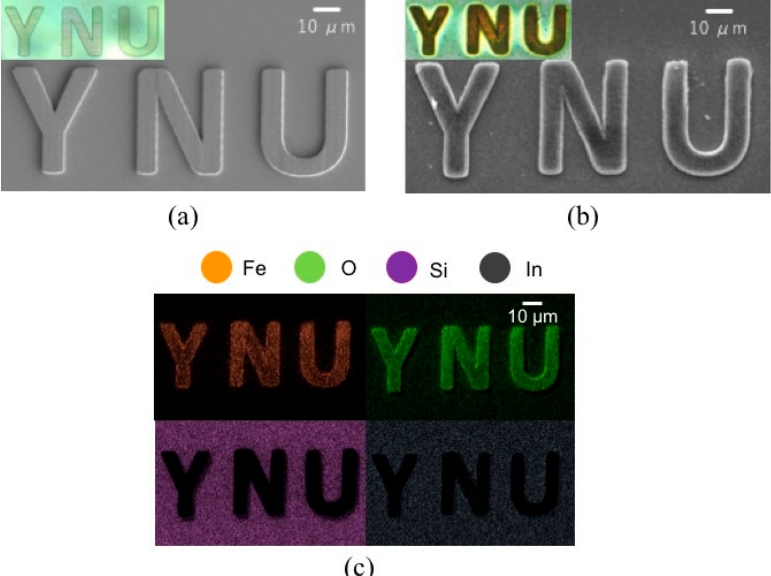
Figure 2. Experimental results of magnetite coating of polymeric microstructures made from the acrylic resin. ( a , b ) Scanning electron microscopy (SEM) image and optical image of the microstructures made from acrylic resin before and after electroless plating. ( c ) Element mappings of the magnetic microstructures (orange: iron, green: oxygen, violet: silicon, gray: indium).